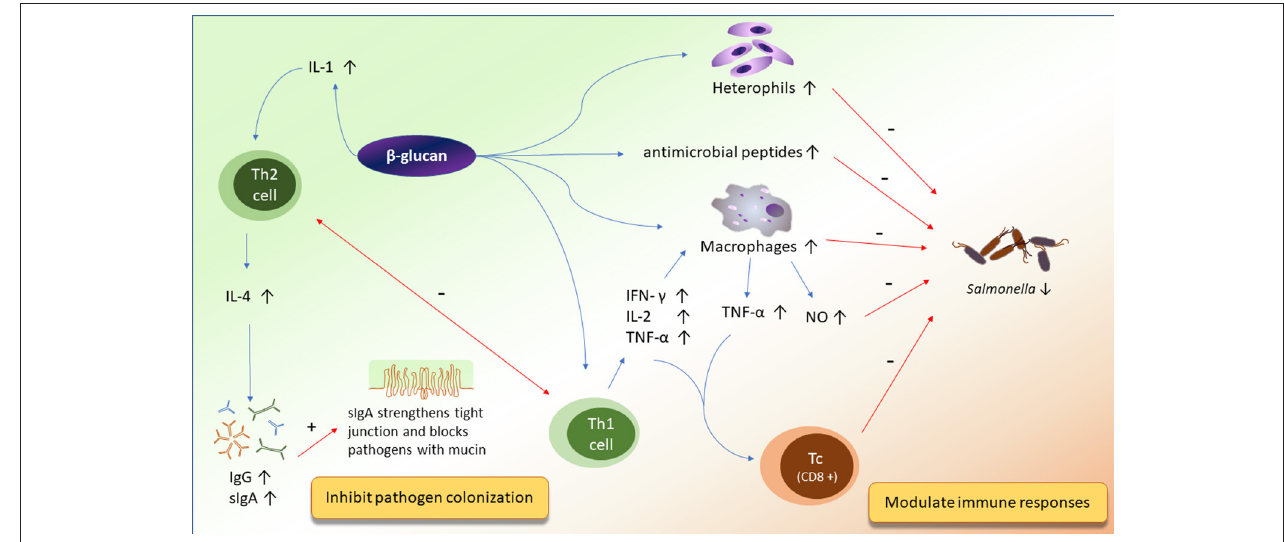
FIGURE 3 | The potential mechanisms of action of β -glucan on improving immunity and inhibiting pathogen